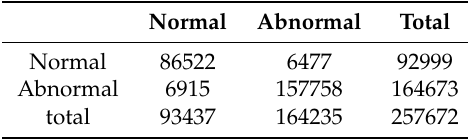
Table 9. The confusion matrix for normal and attacks on Unsw-NB15. Normal Abnormal